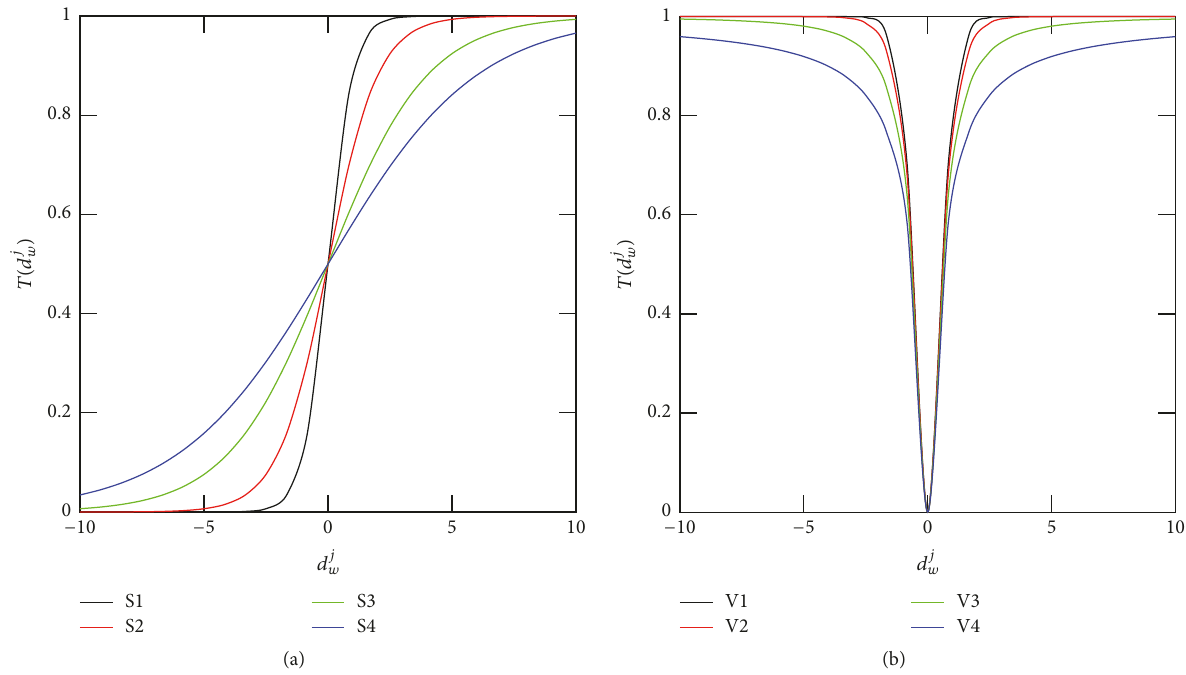
Figure 3: (a) S-shape and (b) V-shape and transfer